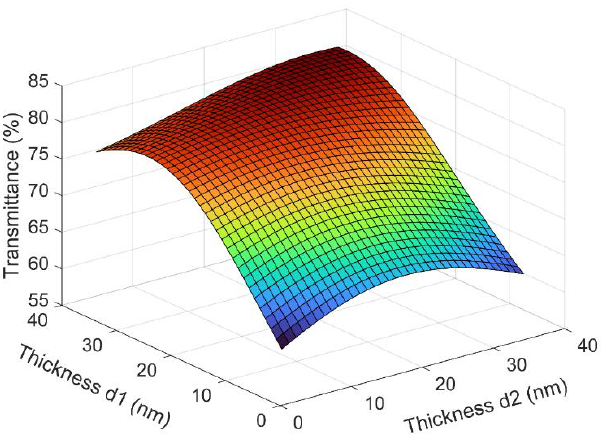
Figure 1. Calculated average transmittance of the polymer/NAN structures as a function of the thickness of the two NiO layers. The wavelength was between 380 nm to 780 nm. The thickness of Ag was fixed at 11 nm.